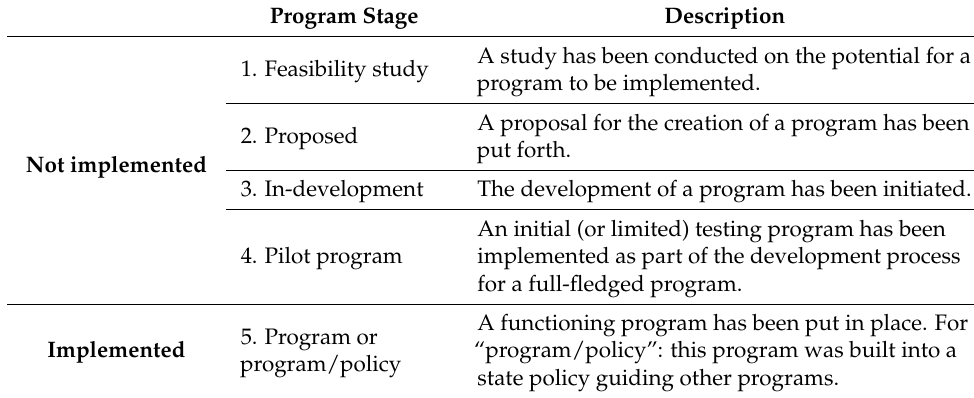
Table 1. Water quality trading program stages, descriptions, and categorization as